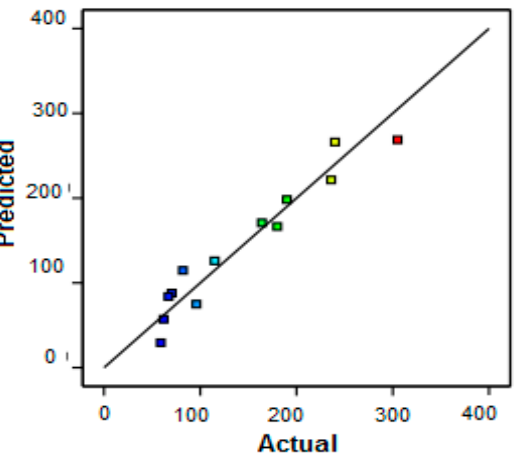
Figure 6. Comparison of calculated and predicted values for permeate flux by RSM. The difference of color for the dots is due to the difference between min and max values of the parameter: min in blue and max in red (given by the software).